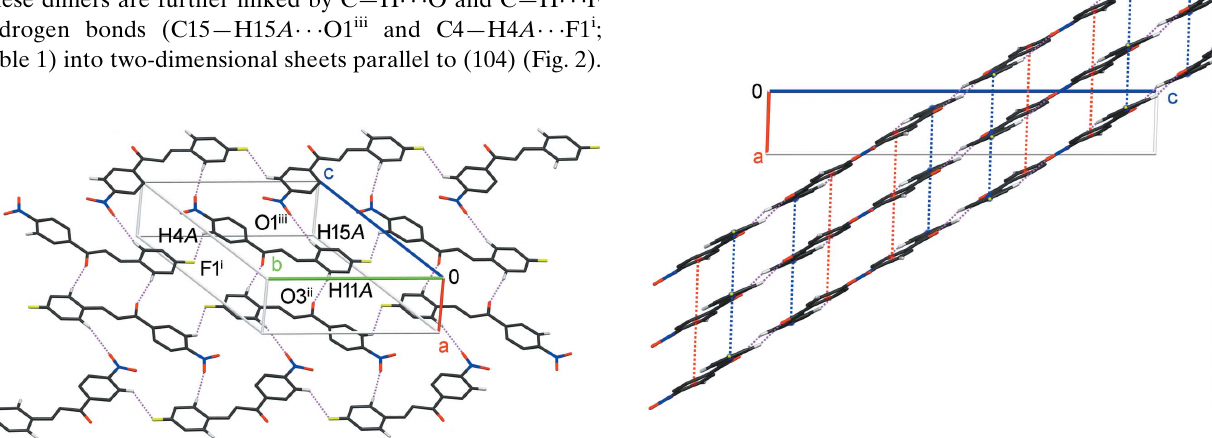
Figure 3 A partial packing diagram of the title compound, showing three separated sheets parallel to (104). The intermolecular (cid:2) – (cid:2) interactions between adjacent sheets are represented as red and blue dashed lines, involving Cg 1 (cid:2)(cid:2)(cid:2) Cg 1 and Cg 2 (cid:2)(cid:2)(cid:2) Cg 2, respectively. Cg 1 and Cg 2 are the centroids of the C1–C6 and C10–C15 benzene rings, respectively.